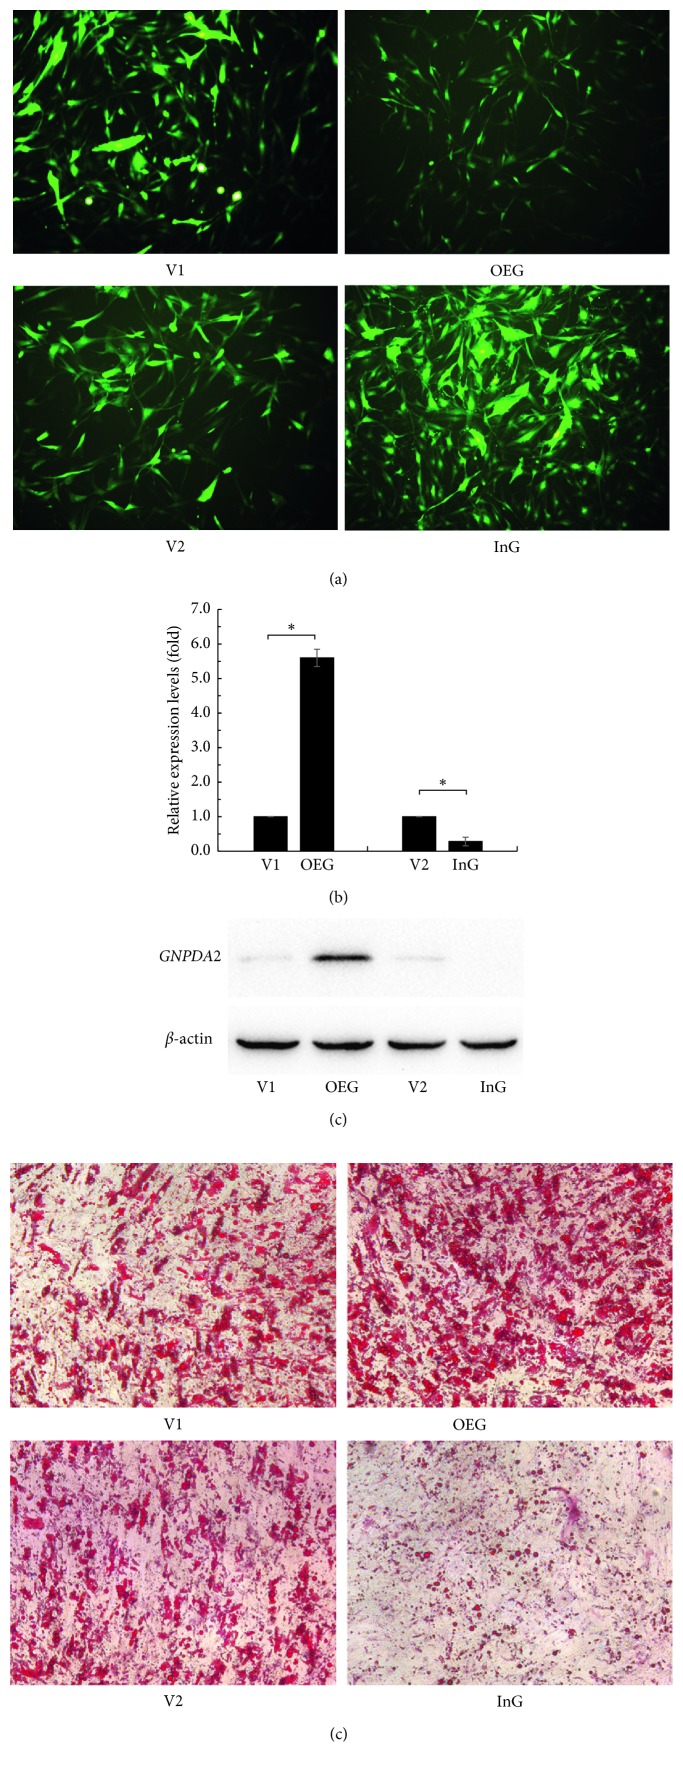
ADMSC transfection and differentiation. (a) GFP expression in OEG, V1, InG, and V2, visualized by fluorescence microscopy. (b) Quantitative RT-PCR analysis of the expression levels of GNPDA2. The relative expression is shown as the means ± standard deviation of three independent experiments made in triplicates. ∗
p < 0.05. (c) Western blot analysis of the protein levels of GNPDA2. (d) Oil Red O staining after 10 days of culture in adipocyte differentiation inductive medium. OEG: GNPDA2 overexpressed ADMSCs; V1: the control cells of OEG; InG: GNPDA2 shRNA knockdown ADMSCs; V2: the control cells of InG.